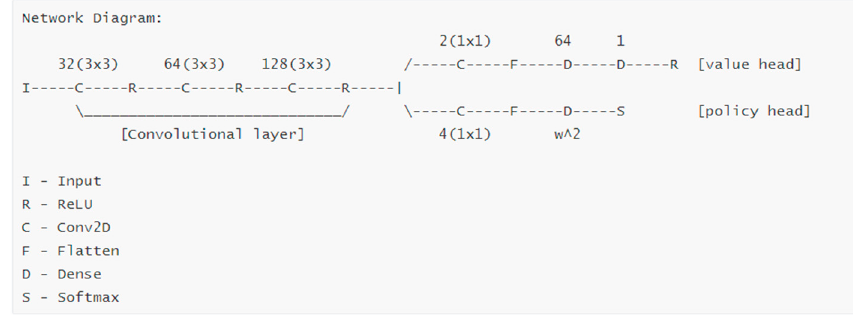
Figure 3. The neural network architecture of the policy function and value function.